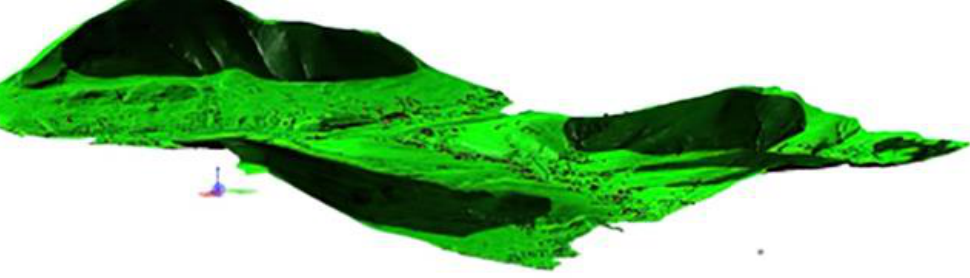
Figure 30. Isometric view of the 3D model of the